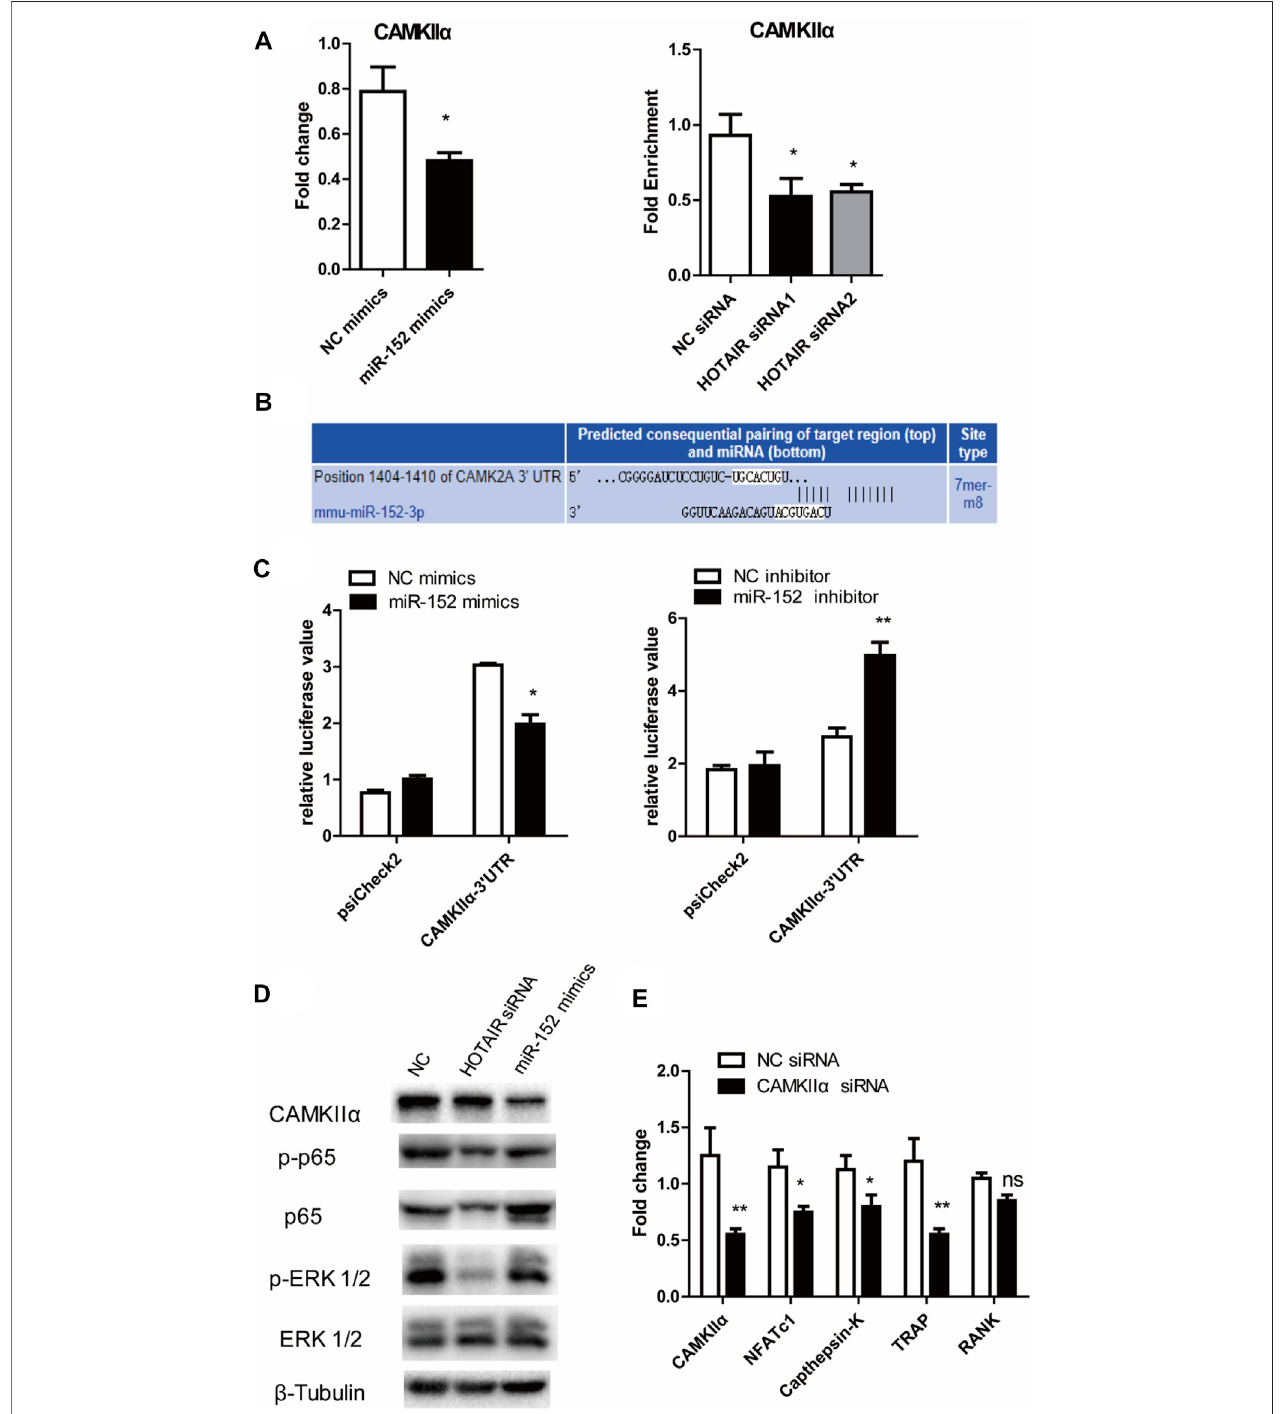
FIGURE 6 | HOTAIR-miR-152-CAMKII α axis regulated osteoclast differentiation and apoptosis through NF- κ B and MAPK/ERK 1/2 pathway (A) Expression of CAMKII α mRNA in both miR-152 overexpressed (left) and HOTAIR-knockdown osteoclasts (right) wasdownregulated (B) Predicted binding sites for miR-152 in the 3 ′ - UTR of CAMKII α (C) RAW264.7 cells were transfected with the control construct (psiCHECK-2), or a construct encoding the wild-type CAMKII α 3 ′ -UTR, in addition to the miR-152 mimics(left)or miR-152 inhibitor (right). After24 hs, luciferase activity inRAW264.7 lysates wasdetected (D) Aftertransfection withHOTAIR siRNA or miR-152 mimics, the protein levels of CAMKII α , Phosphorylated p65, p65, Phosphorylated ERK 1/2, and ERK 1/2 in mature osteoclasts were examined by western blotting. β -Tubulin was used to con fi rm equal protein loading (E) Effect of CAMKII α on osteoclast differentiation-related gene expression in CAMKII α siRNA-treated osteoclasts. Bars represent the mean ± SEM. * p < 0.05, ** p < 0.01. The data are representative of three independent experiments.